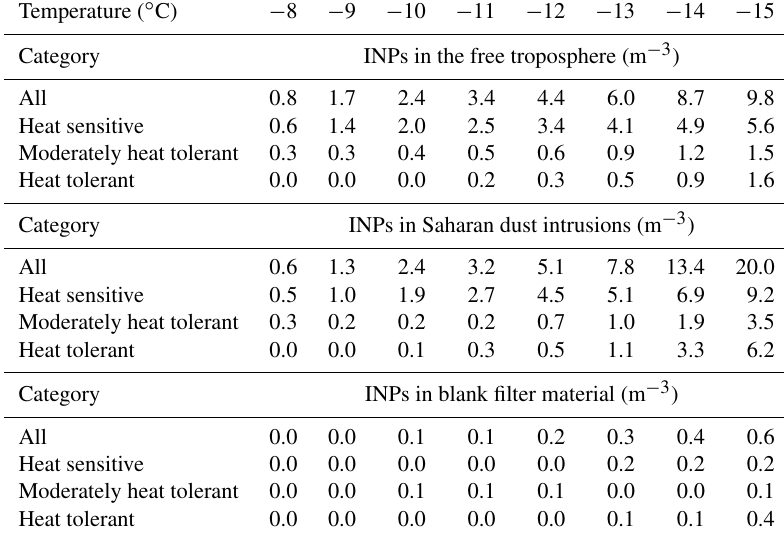
Table A3. Median number concentration of ice-nucleating particles active between − 8 and − 15 ◦ C at Jungfraujoch, determined for free tropospheric conditions and during Saharan dust intrusions, and the average of two assays with blank filter material. The blank values have been subtracted from the sample values before calculating the medians shown in the